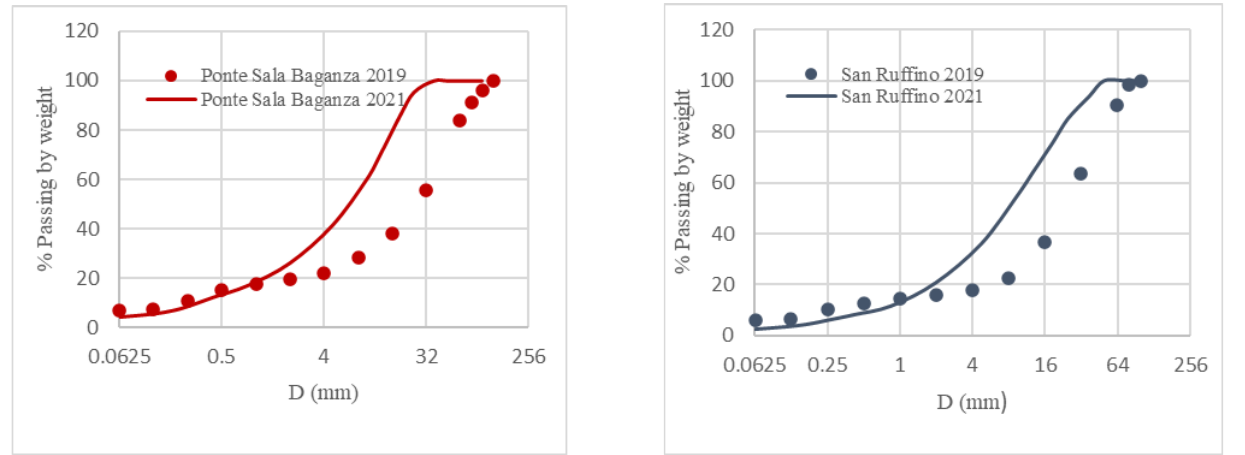
Figure 12. The grain size distribution of the subsurface sediments at the respective sections (sieve analysis).